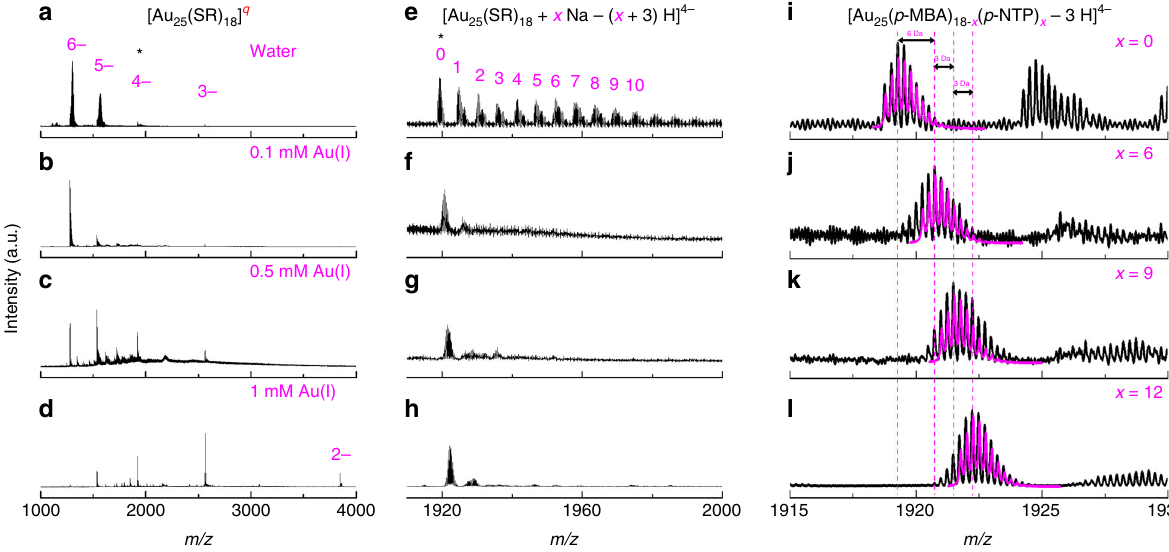
Fig. 3 Size-conversion reaction induced by foreign Au(I)-SR ’ complexes. Electrospray ionization mass spectra of [Au 25 (SR) 18 ] − nanoclusters formed by reacting [Au 23 ( p -MBA) 16 ] − with varied dosage of Au(I)-( p -NTP) complexes, which are expressed by [Au(I)] = a , e , i 0 mM; b , f , j 0.1 mM; c , g , k 0.5 mM; d , h , l 1.0 mM. a – d Broad range spectra at m/z = 1000 – 4000; e – h zoom-in spectra of cluster peaks carrying 4- charges; and i – l experimental (black lines) and simulated (magenta lines) isotope patterns of [Au 25 ( p -MBA) 18- x ( p -NTP) x – 3 H] 4 − with x values indicated in the corresponding panels. SR and SR ’ denote different thiolate ligands, whereas p -MBA and p -NTP are para -mercaptobenzoic acid and para -nitrothiophenol,